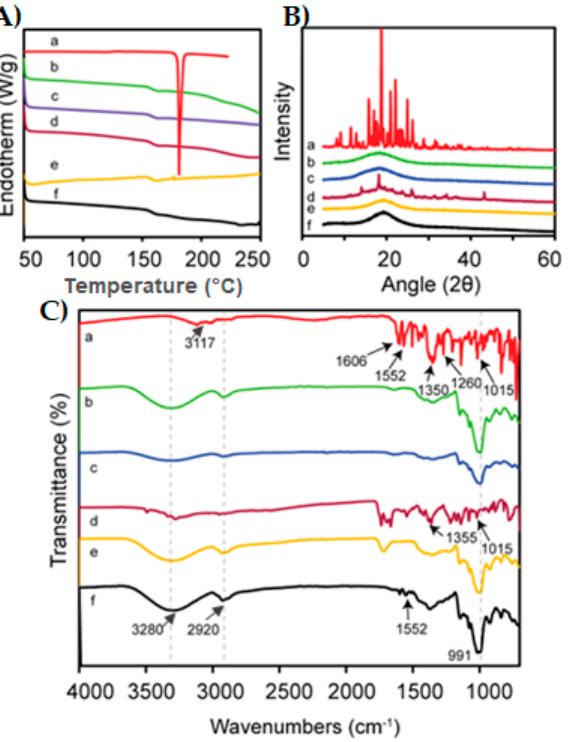
Figure 13. DSC thermo-grams ( A ), XRD patterns ( B ), and FTIR analysis ( C ) of pure RZT (a), MTX (b), PUL (c), physical mixture (d), blank-film (e), and RZT loaded film (f). XRD verified the crystallinity transformation of pure RZT in RZT-ODFs, as shown in Figure 13B. The presence of intense, sharp peaks at 15.8, 18.7, 20.9, 22.1, and 24.9 in the XRD diffract gram of pure RZT demonstrates that active RZT exists in pure crystalline form. The broad peak at 18.3 in the MTX and PUL XRD patterns confirmed the amorphous nature of polymers [31,43]. Some distinctive RZT peaks were observed in the physical mixture. Therefore, the hallo pattern of RZT-ODFs demonstrates the transition of all discrete peaks into a broad peak at 19.3, indicating the loss of crystallinity of RZT and its transformation into an amorphous state